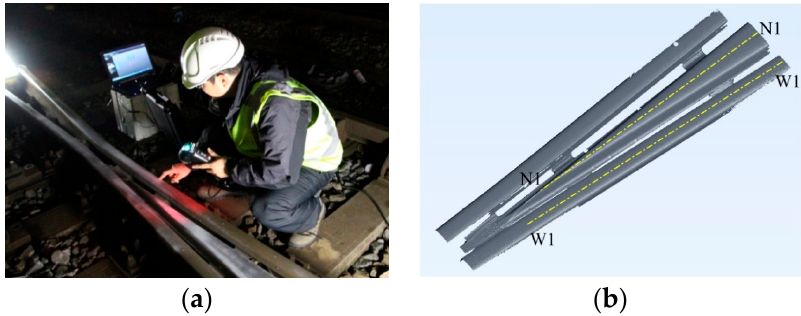
Figure 6. 3D profile measurement. ( a ) Measurement using HandyScan and ( b ) a measured 3D crossing profile. Cross sections W1 and N1 are along the centerlines of the wing rail and crossing nose, respectively.